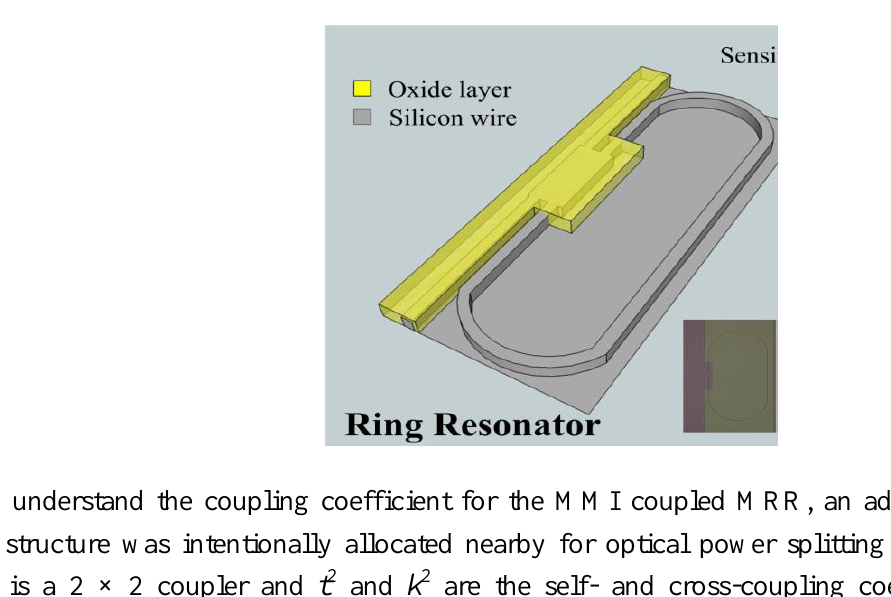
Figure 3. Schematic drawing for the optical ring biosensors (Insets: the optical image for a biosensor sensing part and SEM picture for silicon wire waveguide).